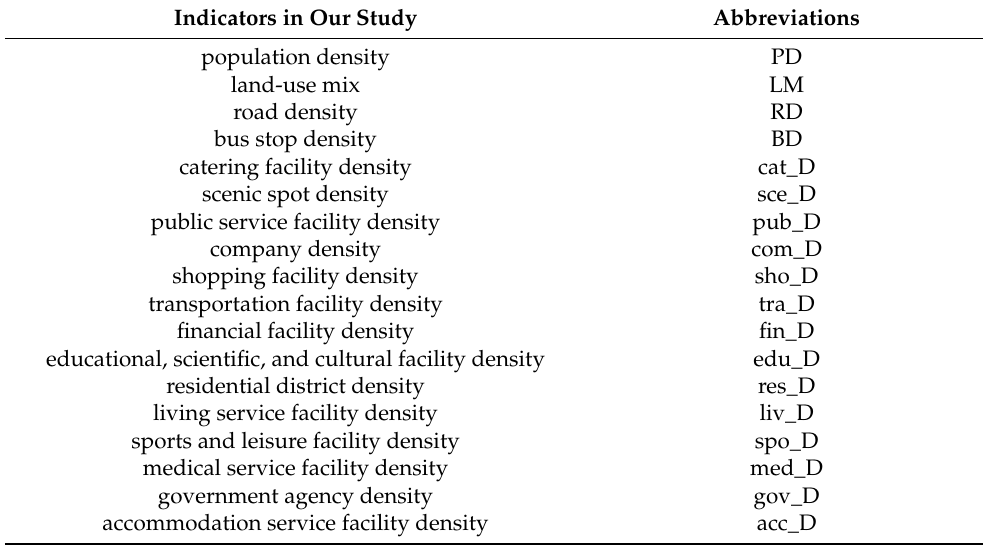
Table 2. The abbreviations of